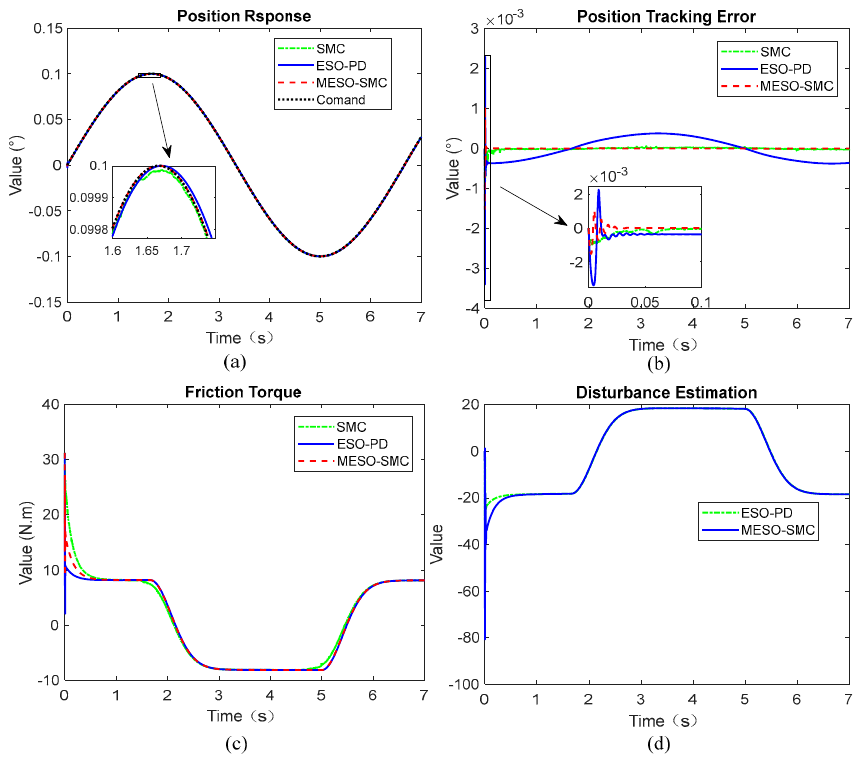
Figure 12. Comparisons of low-frequency simulation: ( a ) Position tracking. ( b ) Position tracking errors. ( c ) Friction torque curves. ( d ) Disturbance